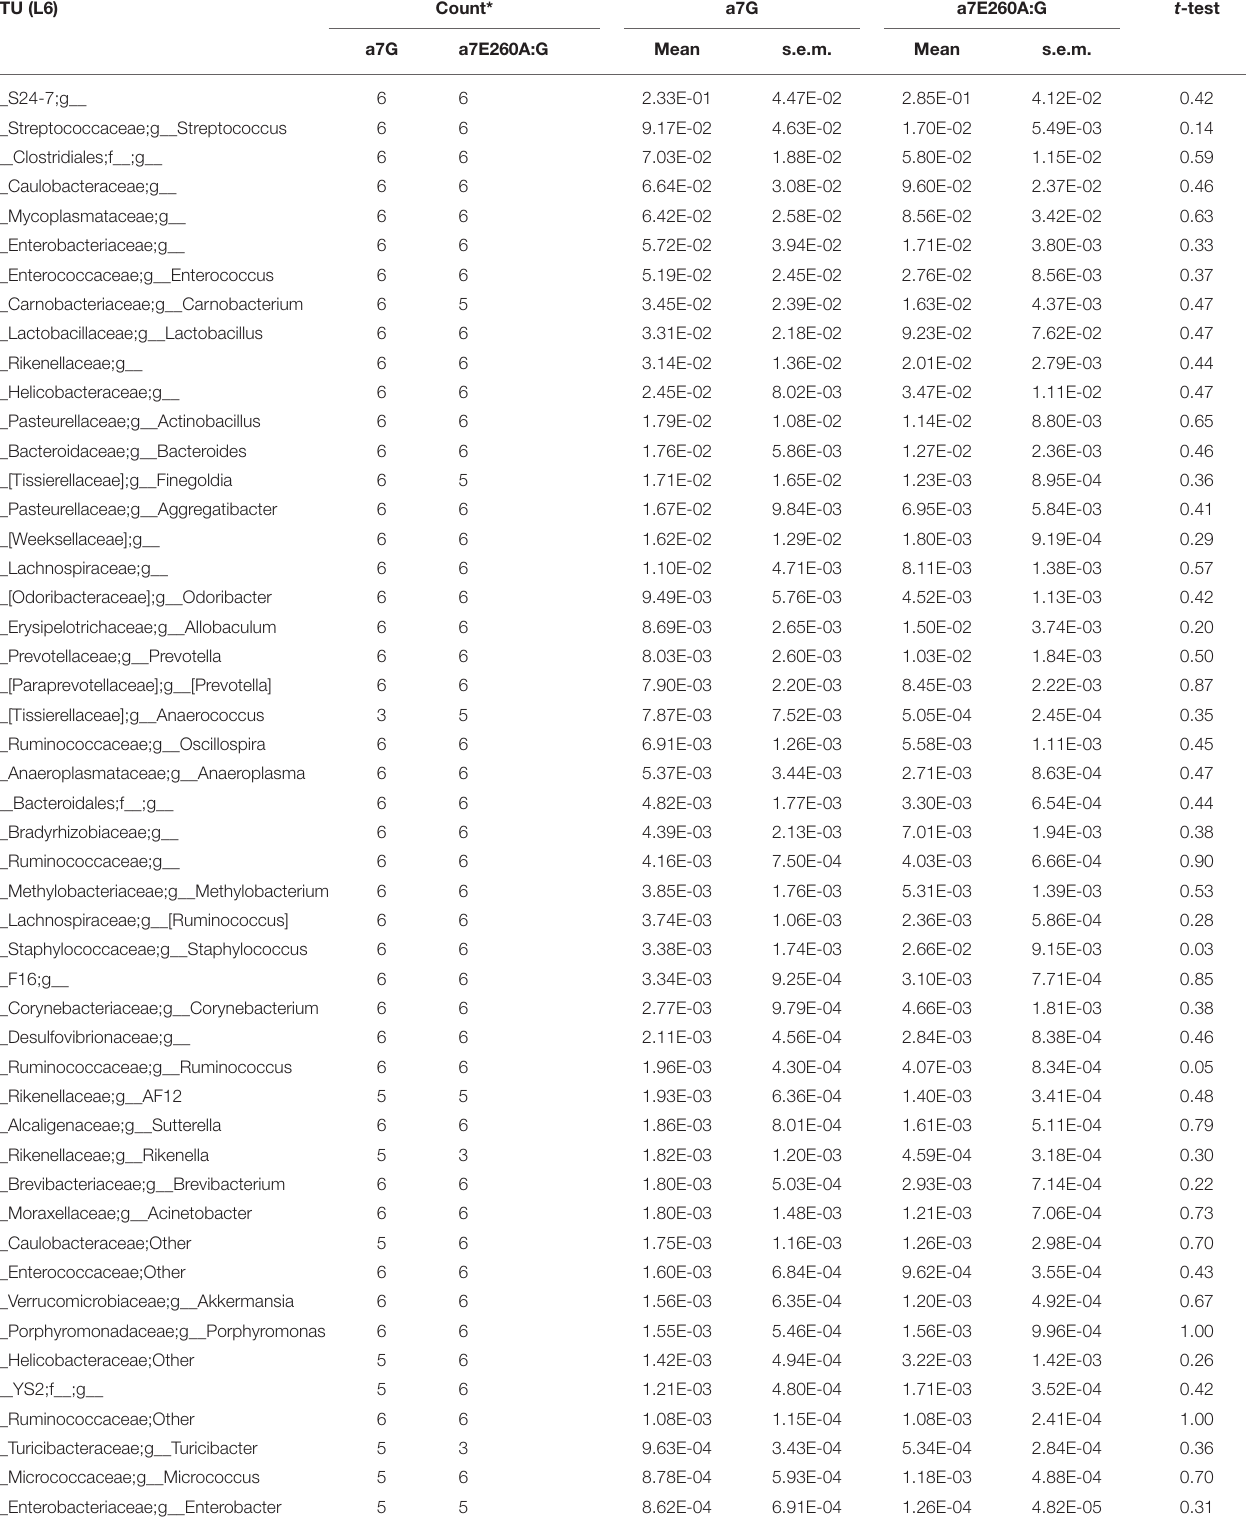
TABLE 1 | The 70 most abundant OTU from α 7 G and α 7 E260A : G mandibles. OTU